Question: In a single sentence, describe what this figure presents.
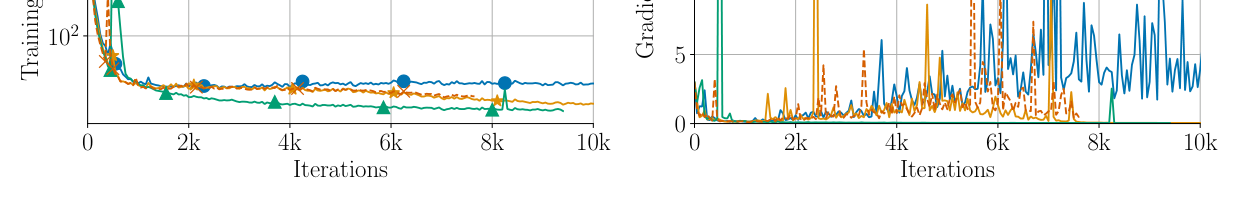
Answer: Openllama 7B pretraining (see settings in Section 5.2) with β2 = 0.99. Left: Training perplexity for different precision strategies listed in Table 2. Right: Model gradient L2 norm across iterations for different strategies. The COLLAGE-plus results in the best train perplexity over iterations while other approaches struggle. The gradient norm blows-up frequently but stays stable for COLLAGE-plus which suggest importance of using multi-components at critical locations.